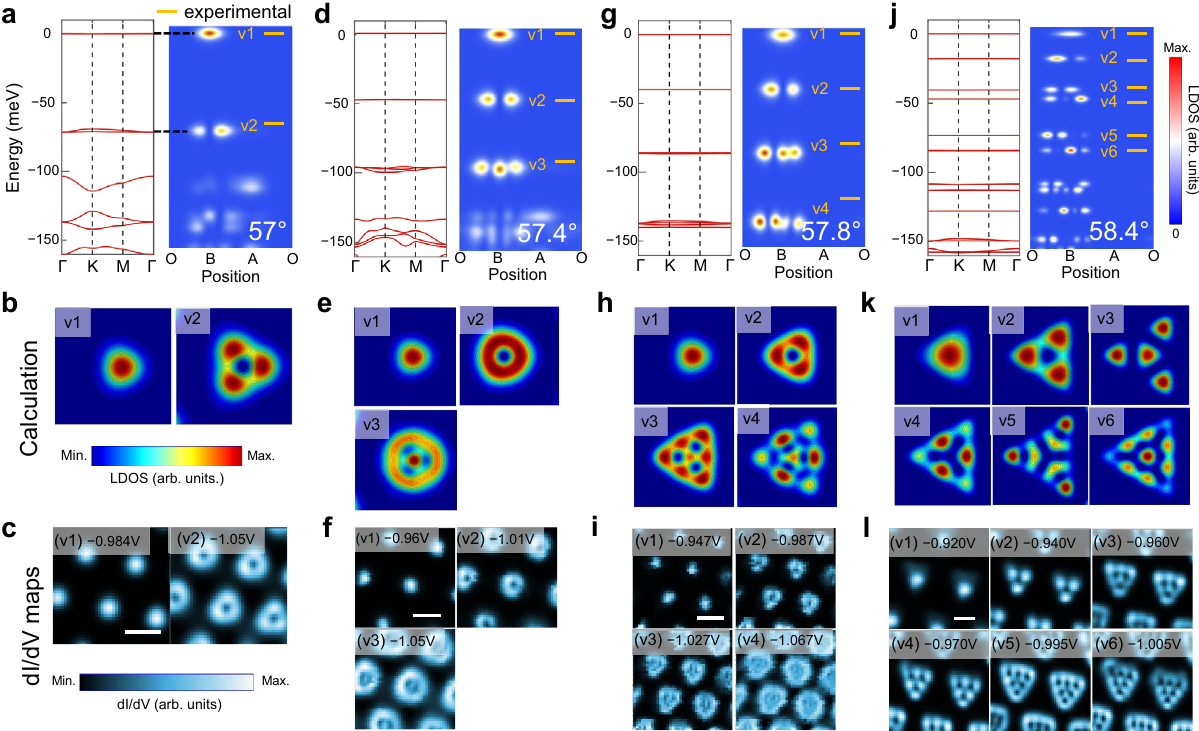
Fig. 3 Evolution of calculated fl at bands with twist angle. a Calculated band structure (left) and the LDOS across the O-B-A-O sites (right) for 57° TB- WSe 2 , showing the ultra- fl at bands and corresponding spatial distributions. The orange lines mark the relative energy levels of the experimental states. Note that the valence band edge is set at E = 0. b Calculated wavefunction patterns of the fl at bands labeled in a . c Measured d I /d V maps for 57° TB-WSe 2 at the energies of B-con fi ned states in Fig. 2c. Scale bar: 4 nm. Similarly, d – f for 57.4°, scale bar in f : 4 nm; g – i for 57.8°, scale bar in i : 6 nm; and j – l for 58.4°, scale bar in l : 5 nm. k and l display the calculated and experimental LDOS maps of fi rst six states in 58.4° TB-WSe 2 ,